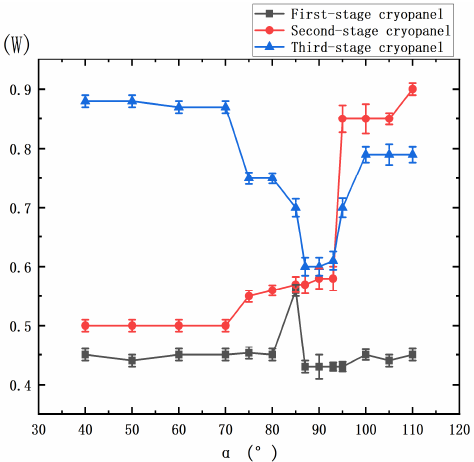
Figure 18. The absorbed radiation of three-stage cryopanels versus α . The influence of L 1 = 10 cm, 12 cm, 14 cm, 16 cm, 18 cm and 20 cm on the absorbed radiation of the third-level radiation baffle was analyzed. As shown in Figure 4, when L 1 increases with the increase of d 1 , d 2 and the radiation heat entering the inlet surface d 2 . The